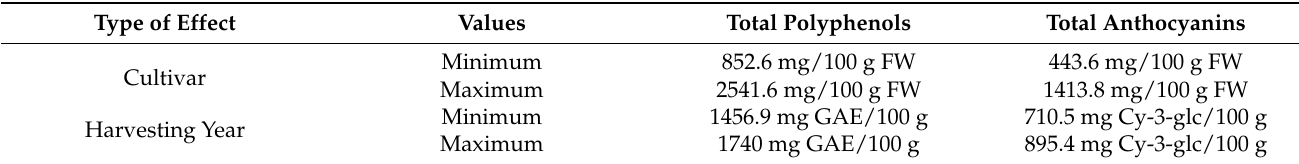
Table 1. Effect of cultivar and harvesting year (3-year study) on the total polyphenol content and total anthocyanin content.